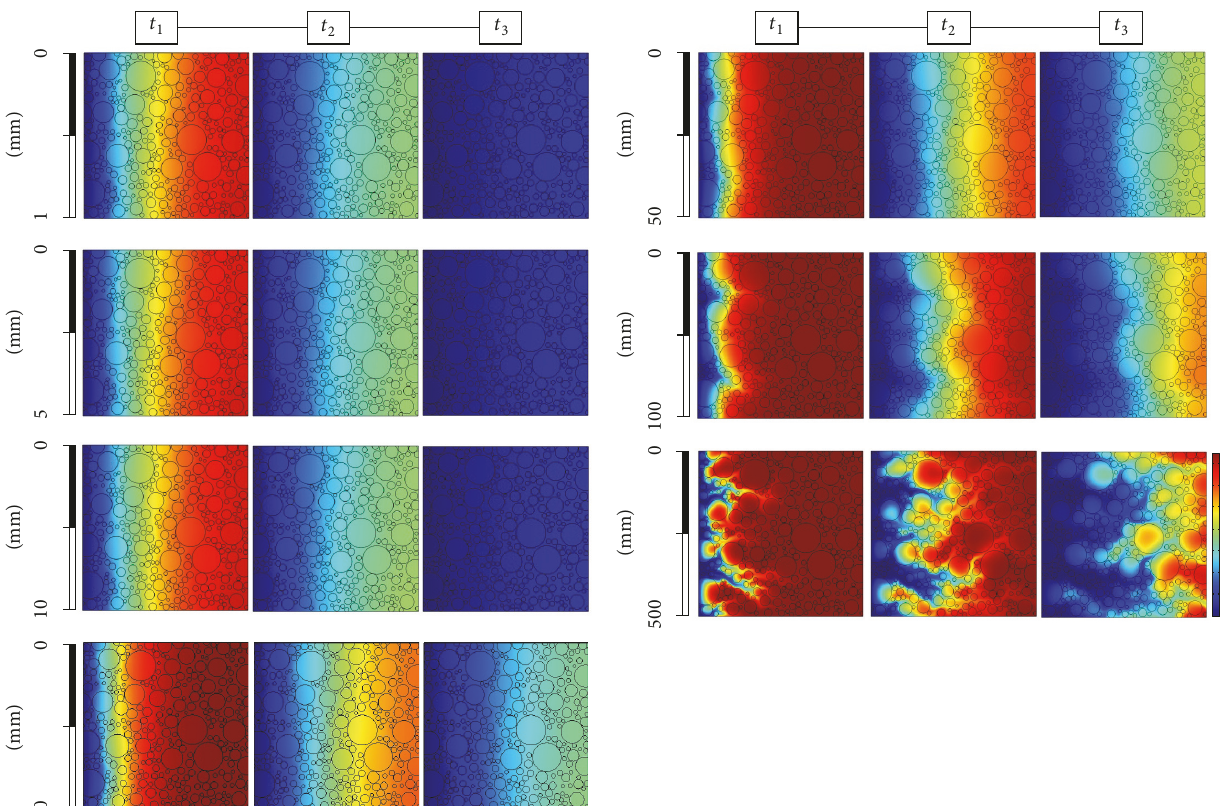
Figure 9: Relative Temperature (RT) for the model with the length scale of 1, 5, 10, 30, 50, 100, and 500